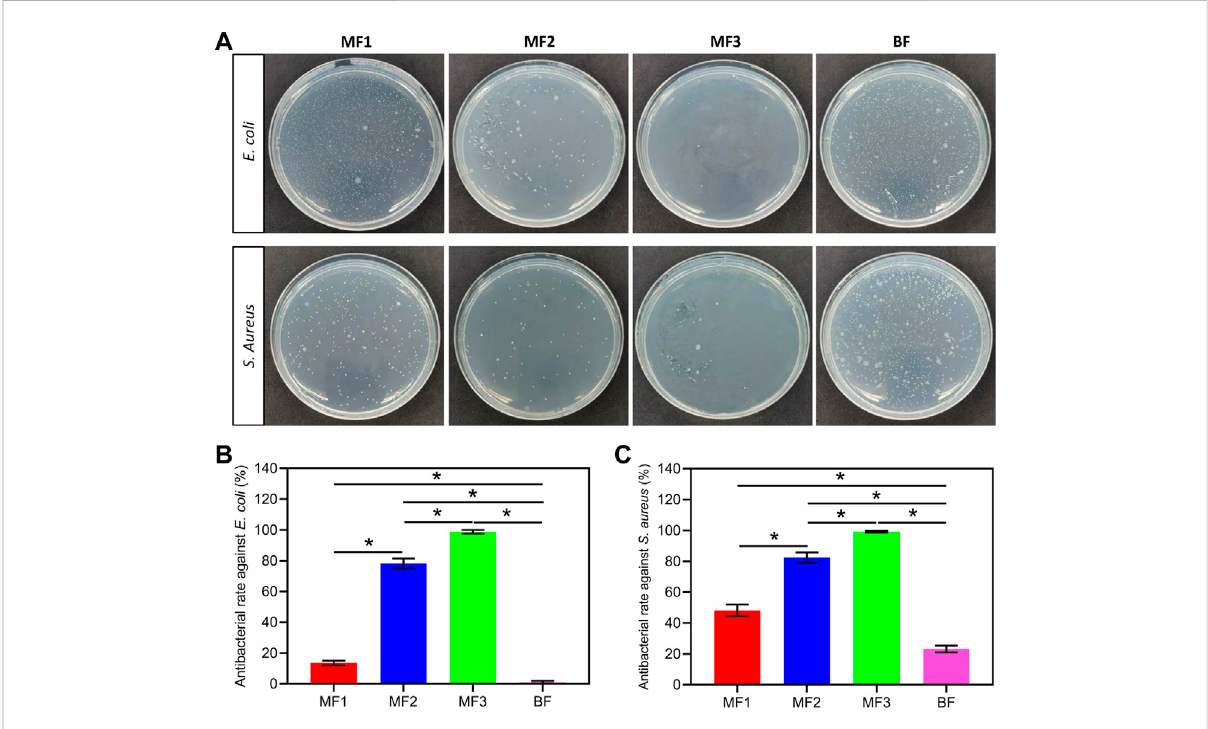
FIGURE 6 Antibacterial activity of the fi lms. Photographs of plate count agar from different groups (A) , and corresponding antibacterial rate against E. coli (B) and S. aureus (C) . * p < 0.05.